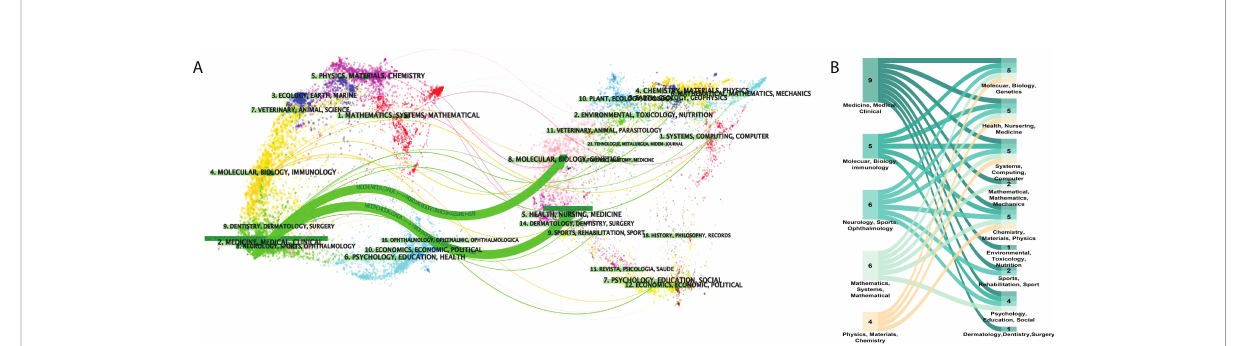
FIGURE 3 Distribution of disciplinaries. (A) Dual-visualization map. The left part was the targeted literature, whereas the right part was the source literature. Each dot represents one journal. On the left, there are the citing journals of this fi eld and, on the right, lay the cited journals in this fi eld. The waves linking to two sides mean that the publications on the journals on the left side may cite publications from the journals on the right-hand side. (B) Sankey diagram. The numbers on the graph show the amounts of publications in each disciplinary. Disciplinaries shown on the left are the subjects of citing literature and on the right-hand side lays the subjects of cited ones. The color represents citation relationships of corresponding